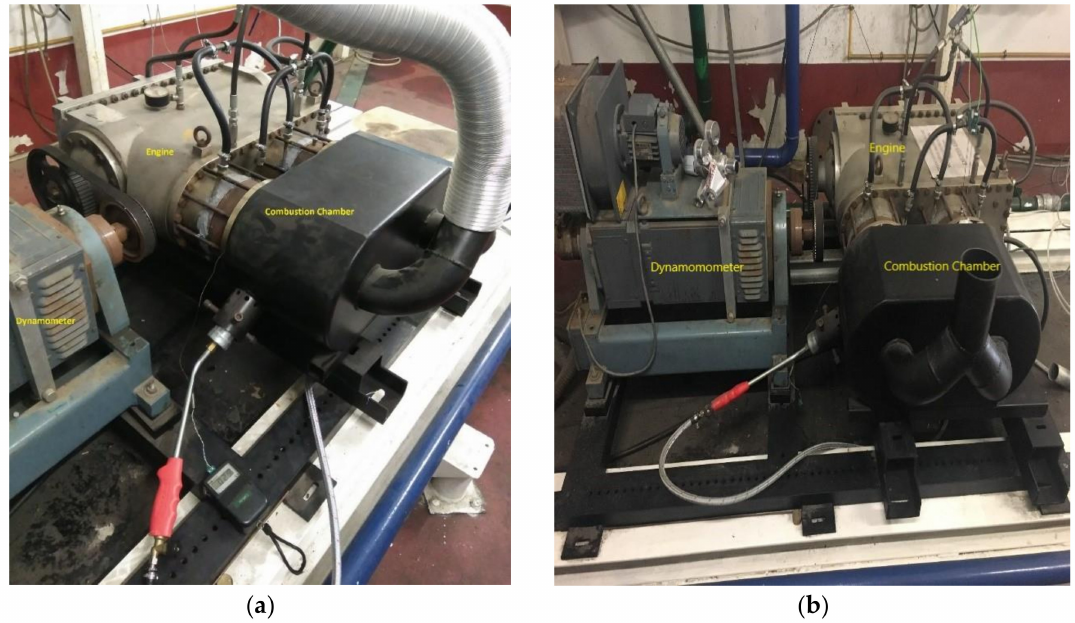
Figure 3. The experimental installation of the engine test. ( a ) Back view; ( b ) Side